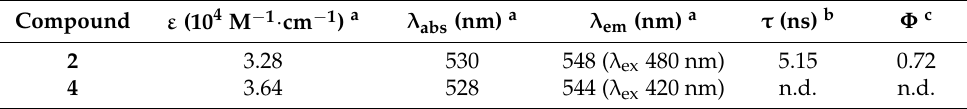
Table 1. Photophysical properties of 2 and 4 .